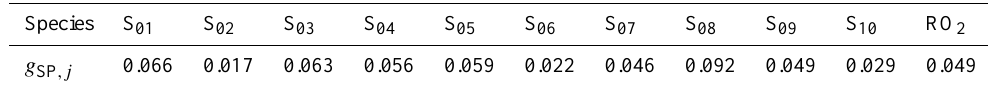
Table 1. The CV(RMSD) ( g SP ,j (j = 1 ,..., 11 )) for the 11 species from 10 different scenarios.